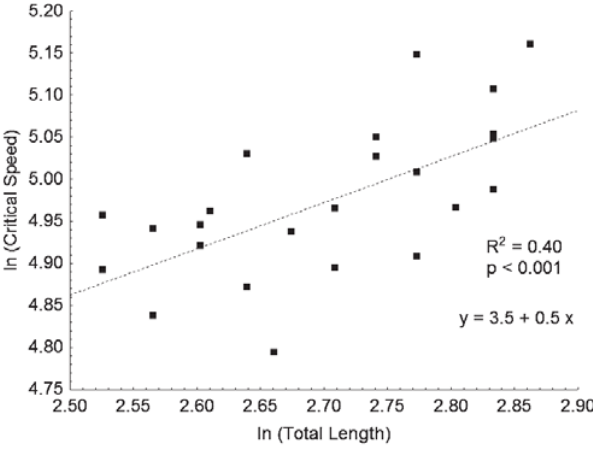
Fig. 3. Scatterplot of the relationship between ln of the criti- cal speed (cm/s) and the ln of the total length (cm). Dotted line represents the fit of the model.